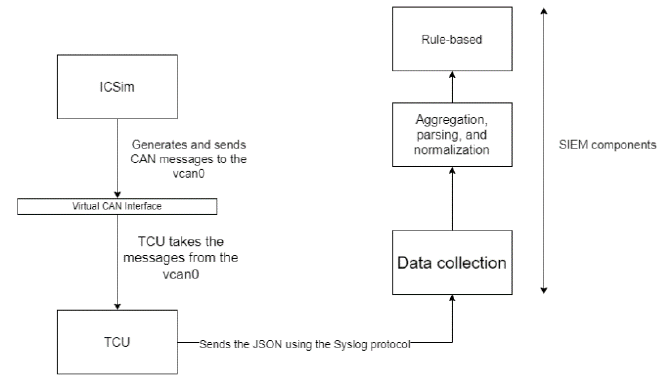
Figure 8. The simulated architecture using ICSim and IBM Qradar.